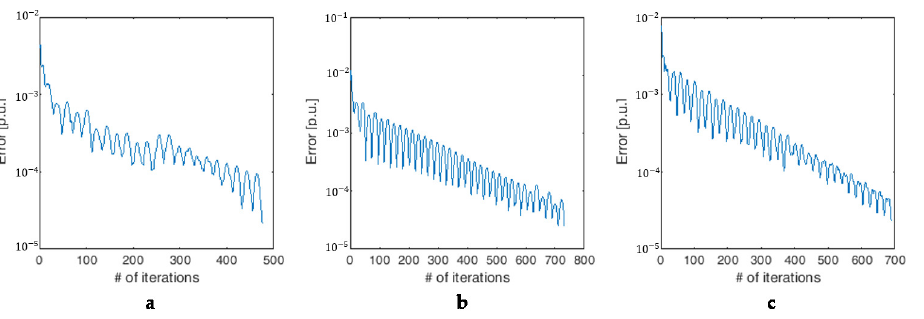
Figure 14. Coupling error of the Decentralized APP for the partition in seven VCZs: ( a ) Case 1, ( b ) Case 2, ( c ) Case